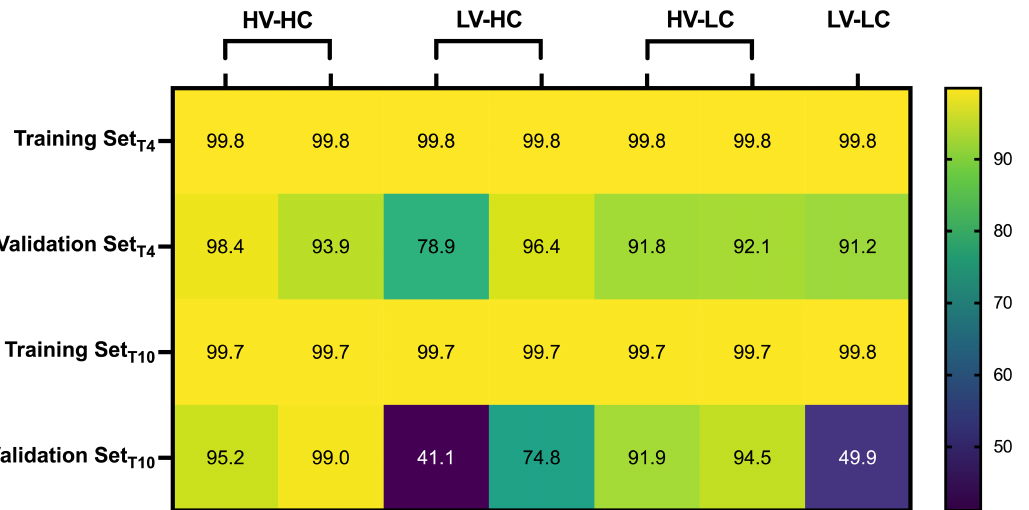
Figure 5. A heat map distribution of the percent accuracies for the respective High Voltage-High Conductivity (HV-HC), Low Voltage-High Conductivity (LV-HC), High Voltage-Low Conductivity (HV-LC), and Low Voltage-Low Conductivity (LV-LC) training and validation sets during the training phase of the model